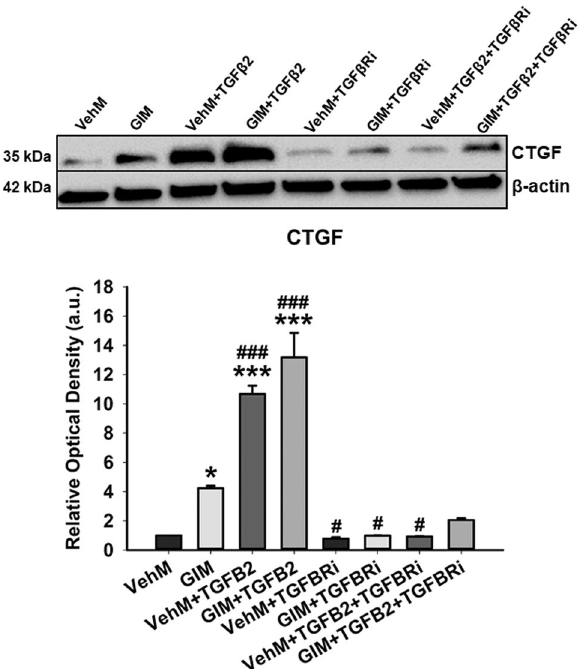
Figure 9. GIM- and/or TGFB2-induced overexpression of connective tissue growth factor in hTM cells is attenuated by TGFβRI kinase inhibitor. Primary hTM cells were cultured in the presence or absence of 100 nM dexamethasone for 4 weeks in complete growth media. Cells were subsequently removed using 20 mM ammonium hydroxide solution to obtain GIMs and vehicle control matrices (VehMs). Same strain, fresh primary hTM cells were then seeded on these matrices with or without exogenous 5 ng/ml TGFβ2 and/ or 5 µM type I TGFβ receptor (TGFβRI) kinase inhibitor in 1% fetal bovine serum growth media for 24 hours. Protein was extracted for Western blot analysis. β-Actin was used as a housekeeping protein for normalization. Representative cropped blot (top) and densitometric analysis (bottom) of connective tissue growth factor (CTGF). Columns and error bars ; means and standard error of mean (SEM). One-way ANOVA with the Tukey pairwise comparisons post hoc test was used for statistical analysis. (n = 4 biological replicates. *p < 0.05, ***p < 0.001 for the group of interest versus control, VehM. # p < 0.05, ### p < 0.001 for the group of interest versus GIM).TGFβ2, Transforming growth factor β2, TGFβRi, type I TGFβ receptor kinase inhibitor. hTM, human trabecular meshwork. Black horizontal demarcating lines between the blots indicate two images taken from two different parts of the same membrane blot. Full length blots can be found in Supplementary Figs. S5G and S6G. Densitometric analyses was done using ImageJ 1.8.0_112 software (https ://image j.nih.gov/ij/,